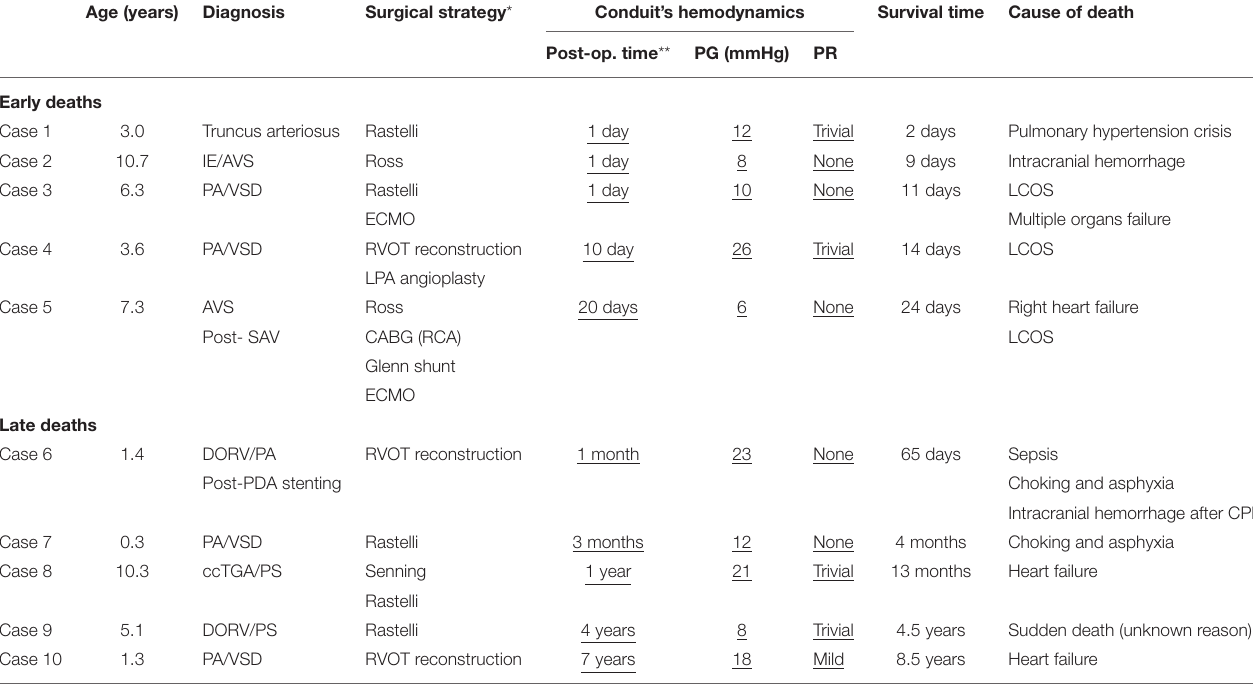
TABLE 2 | Operative data and the main causes for the early and late deaths ( n = 10). Age (years)